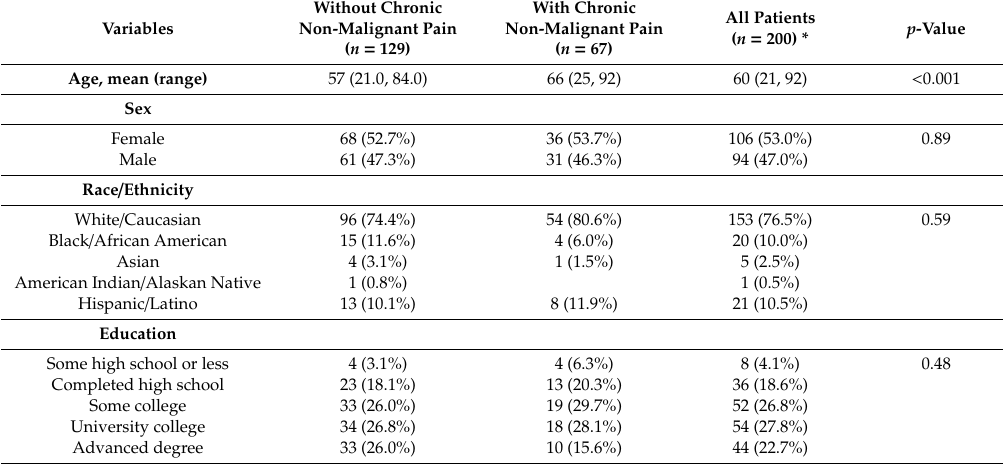
Table 1. Baseline characteristics for patients with or without chronic non-malignant pain ( n =